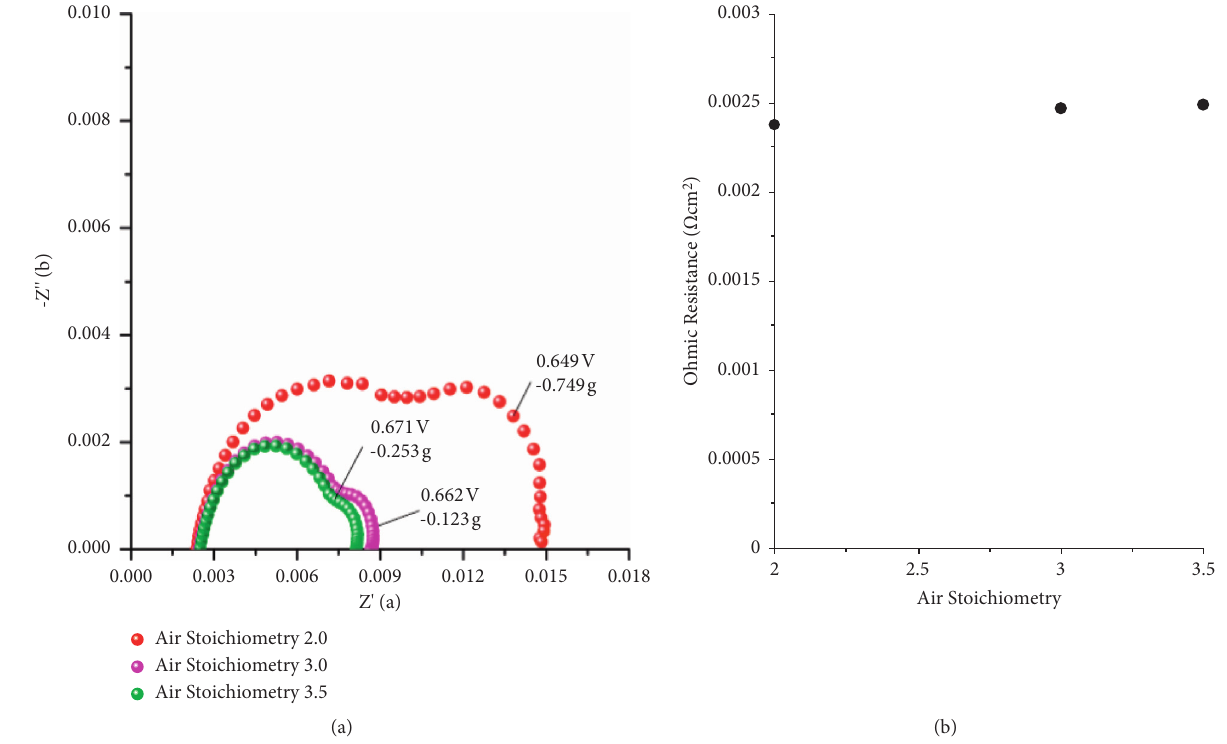
Figure 11: Effect of air stoichiometry on the voltage, water content in the fuel cell, EIS, and ohmic resistance (inlet gas temperature 75 ° C, inlet gas humidity 100%, and hydrogen stoichiometry 1.5). (a) EIS. (b) Ohmic